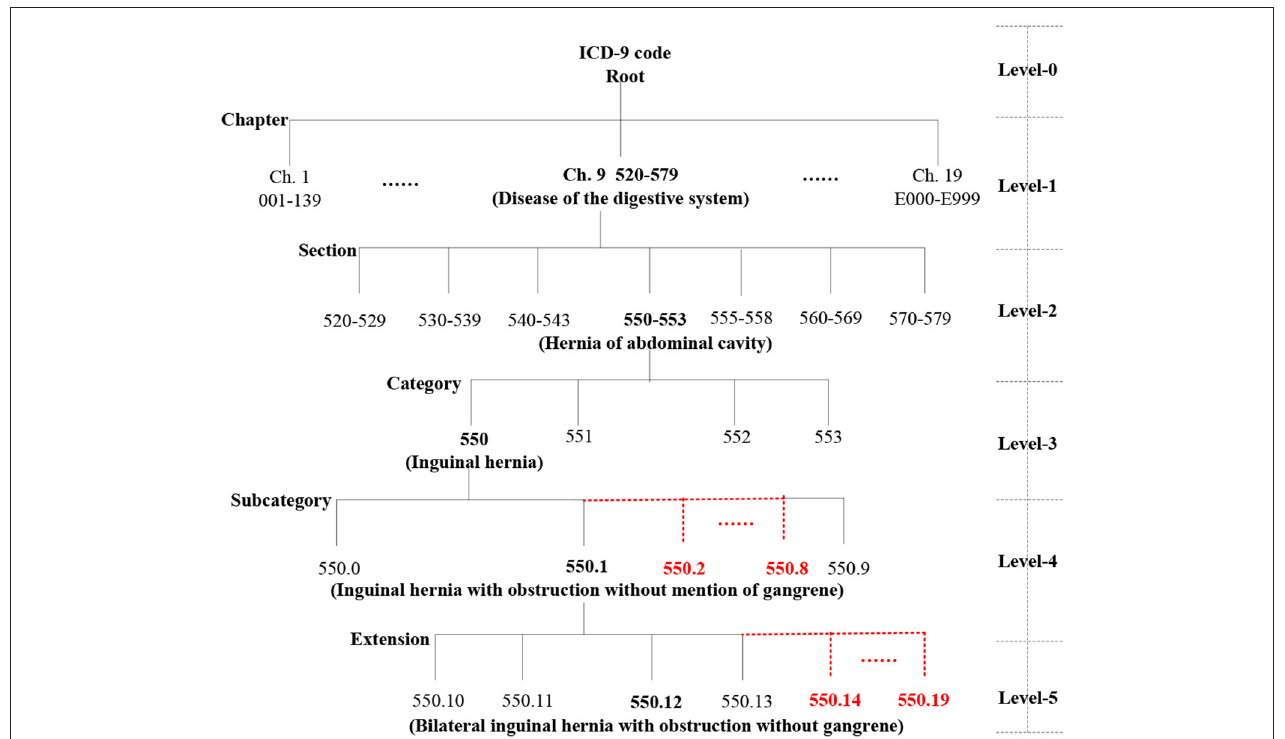
FIGURE 3 | Local ontology structure of ICD-9